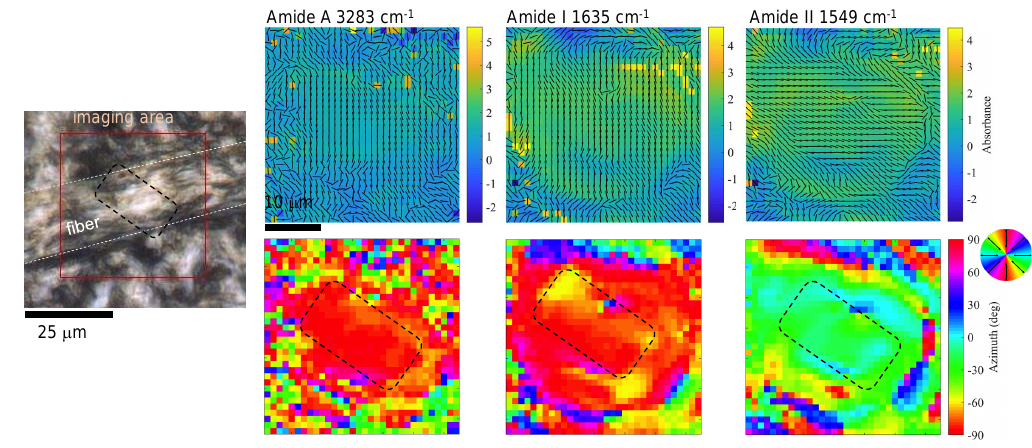
Figure 7. Characterisation of brown silk micro-slice (flat-longitudinal) with synchrotron IR beam. Optical image of a flat longitudinal micro-slice of brown silk fibre in an epoxy matrix and maps of absorbance and azimuth. The black dotted rectangle marks the focal region of focused synchrotron radiation